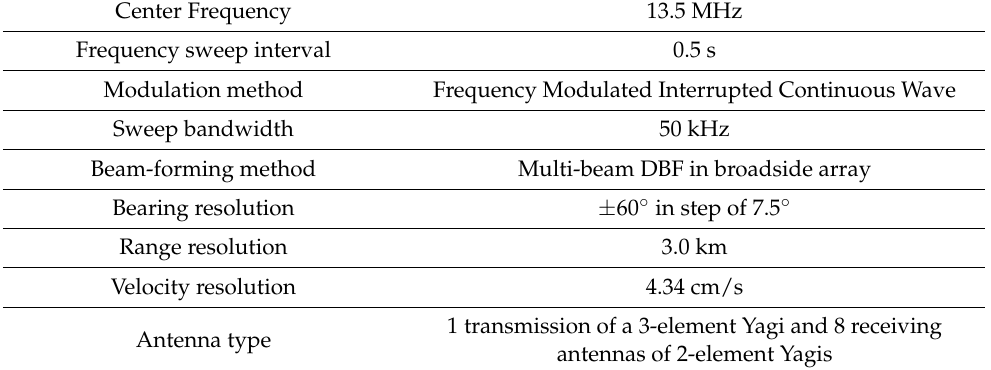
Table 1. Specifications of two HF radar stations installed in Miyazaki Prefecture.